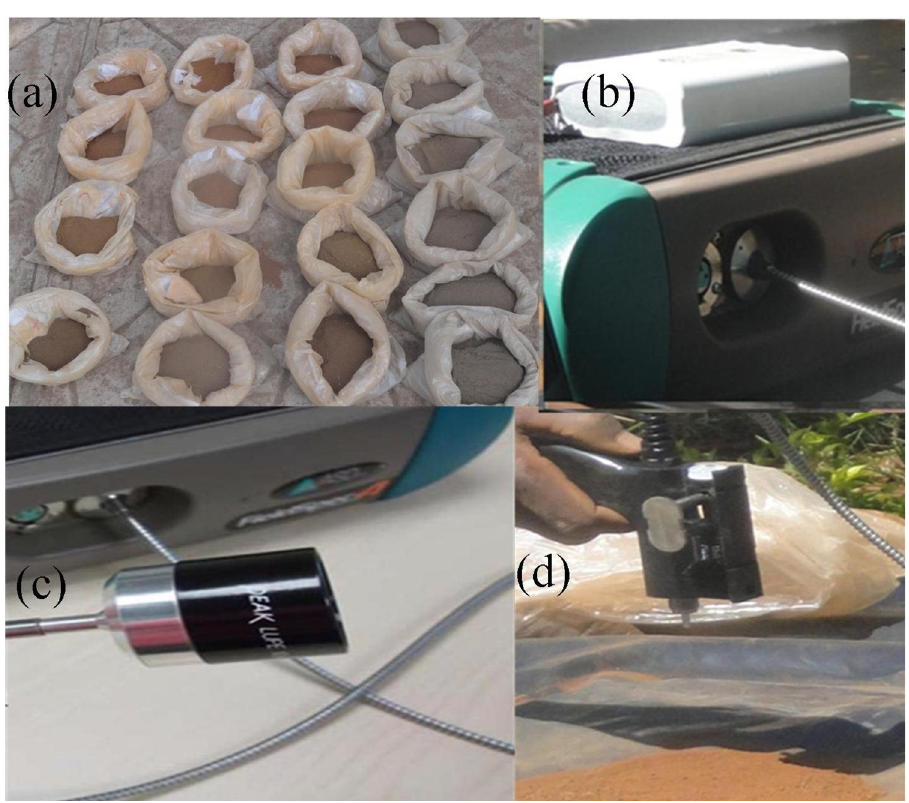
Fig 4. Soil spectral measurement: (a) soil samples, (b) FieldSpec Pro spectroradiometer with battery, (c) a close-up of fiber optic cable, and (d) soil reflectance measurement with the sensor.